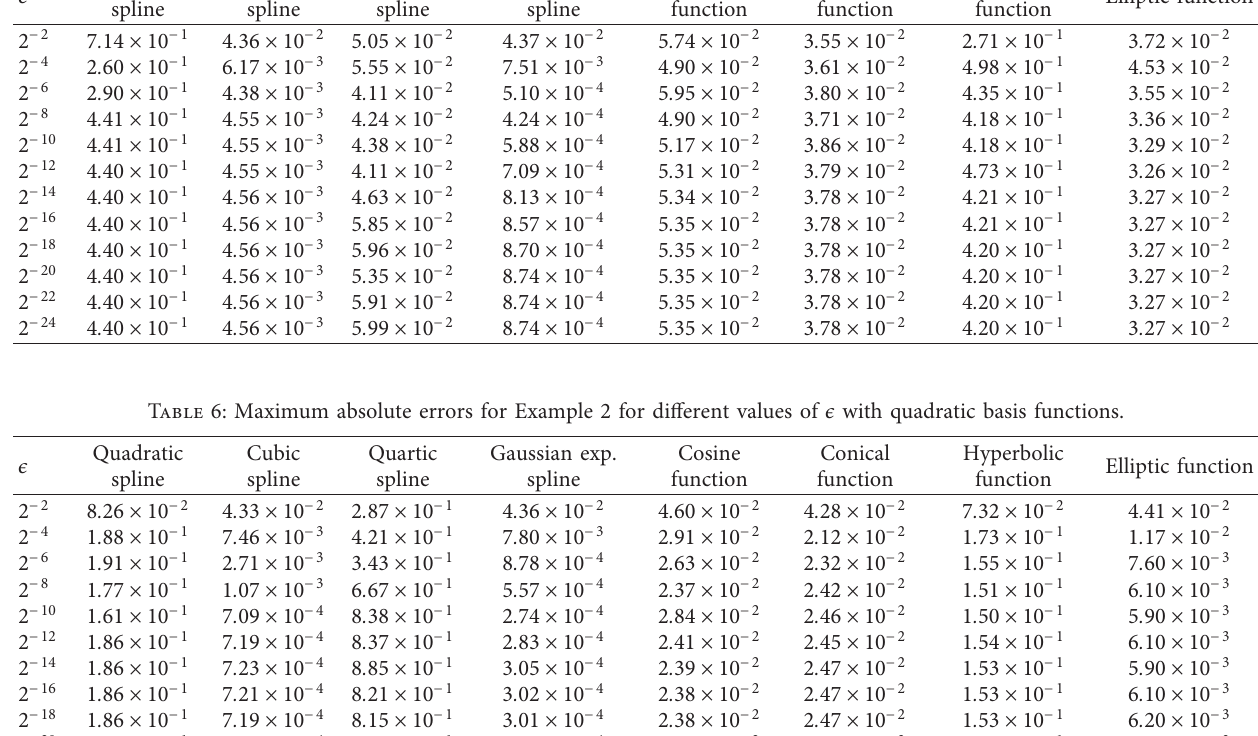
Figure 4: (a) Exact and EFG solution plot. (b) Pointwise absolute error plot for ϵ � 10 − 4 and N � 128 for Example 1 using linear basis and cubic spline weight functions. Table 5: Maximum absolute errors for Example 2 for different values of ϵ with linear basis functions. Quadratic ϵ spline